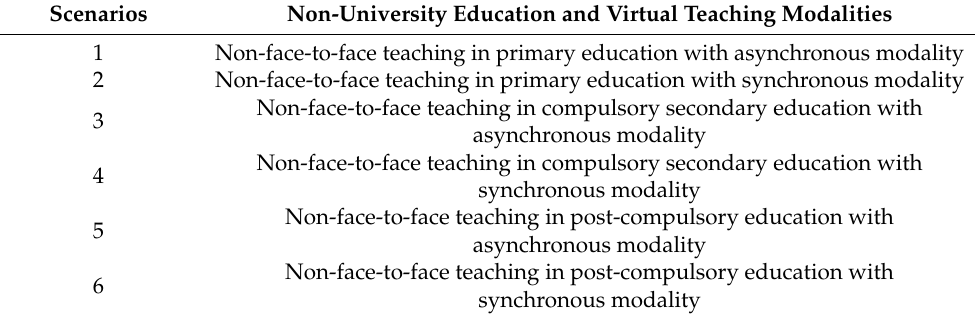
Table 3. Scenarios designed for non-university education for the collection of information from the expert judges through the completion of the